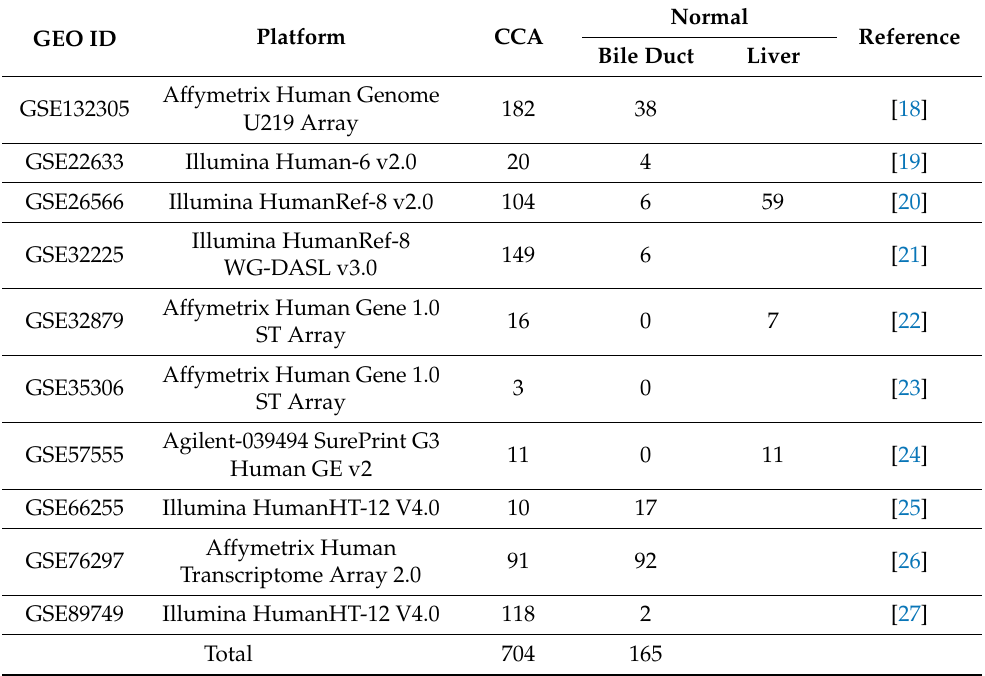
Table 1. Databases used in the bioinformatics analysis of the gene expression profile in CCA. GEO